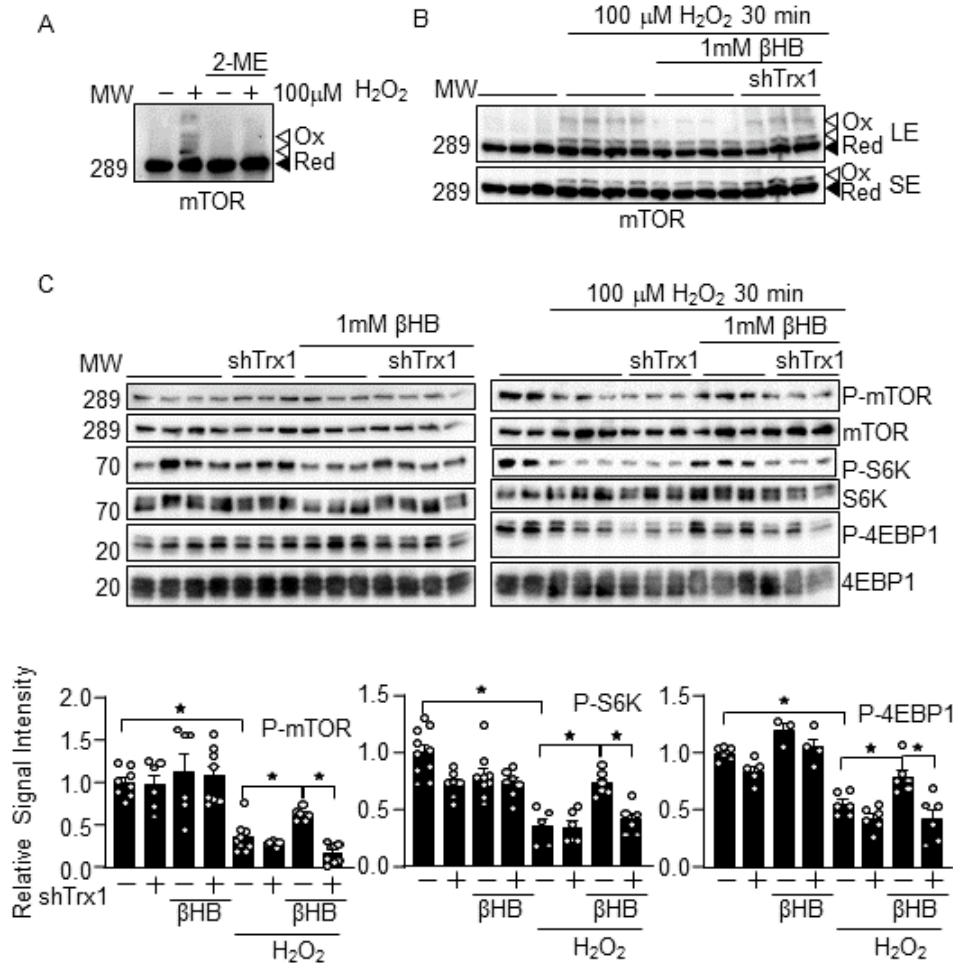
Figure 3. β HB potentiates mTOR function in a Trx1-dependent manner. ( A ) mTOR exhibits intermolecular disulfide bond formation upon oxidation. Cardiomyocytes were treated with 100 µ M H 2 O 2 for 30 min. Western blot analyses were performed following SDS-PAGE under non-reducing (without 2-ME) and reducing (with 2-ME) conditions. ( B ) β HB inhibits H 2 O 2 -induced mTOR oxidation in a Trx1-dependent manner. Cardiomyocytes were treated with 1 mM βHB for 4 h and were then treated with 100 µM H 2 O 2 for 30 min. LE: long exposure, SE: short exposure. ( C ) βHB normalizes H 2 O 2 -induced mTOR inhibition in a Trx1-dependent manner. Western blot analyses were performed with indicated antibodies. n = 6–9 (p-mTOR), 3–6 (P-S6K), and 3–6 (P-4EBP1). * p < 0.05 ( C ).